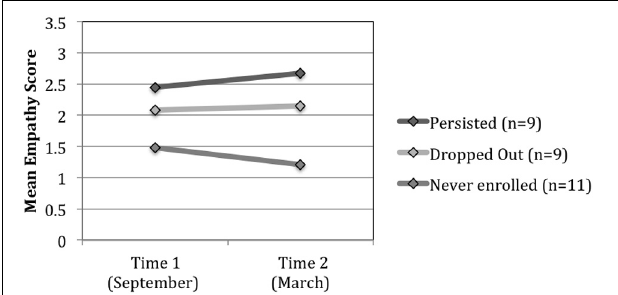
FIGURE 1 | Between-subjects effect for group persistence, F (2, 26) = 7.88, p = 0.004. Post hoc comparisons revealed with a significant difference ( p = 0.003) in Time 1 empathy scores between children who persisted in group class between Time 1 and Time 2, compared to those who never